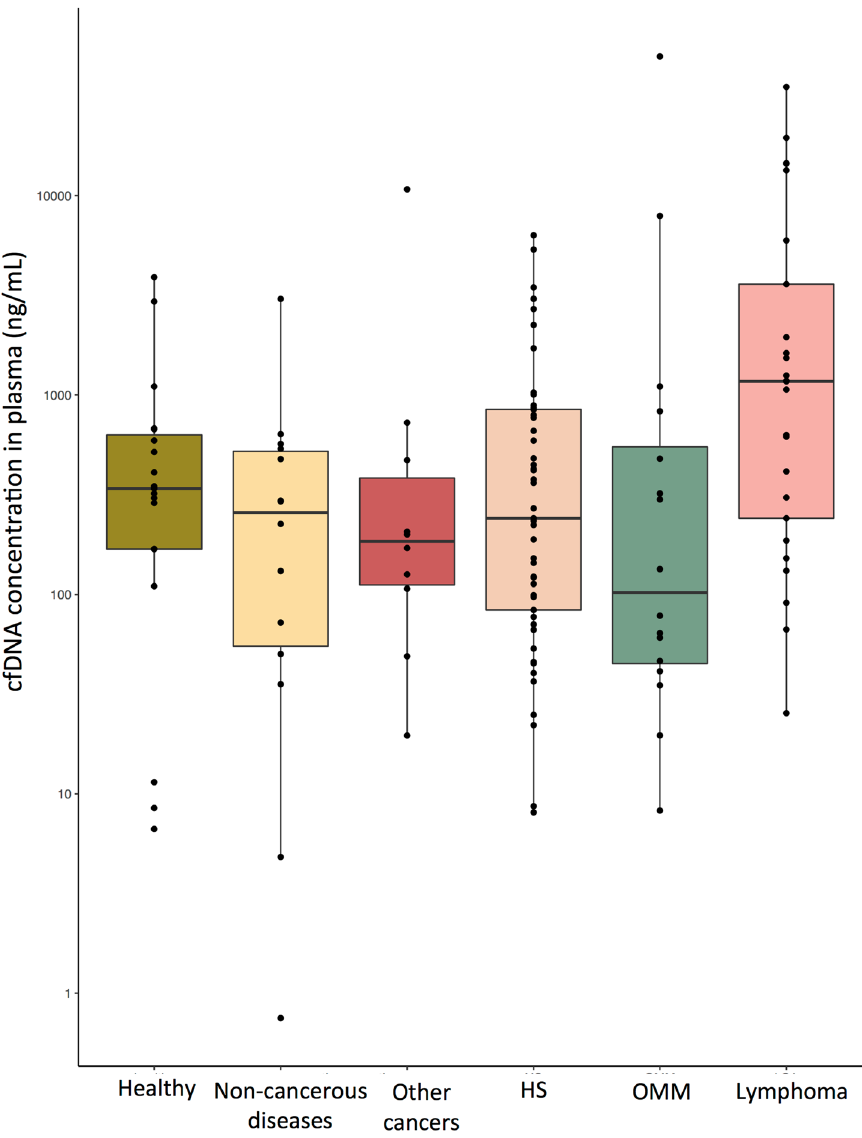
Figure 1. Quantification of cfDNA (ng/mL) in the plasma of dogs in different conditions: healthy, non- cancerous disease, various cancers, HS, OMM, and multicentric lymphoma (drawing produced by R studio software Version 1.1.463; Vienna, Austria 60 ). The amount of DNA was determined via the Poisson